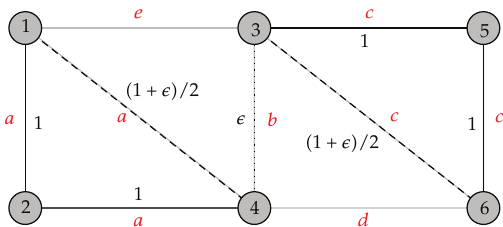
Figure 10: Valid LP-solution of EC tn with f lp (cid:6) 2 (cid:9) (cid:3) (cid:2) l a (cid:6) 1 ,l b (cid:6) (cid:3),l c (cid:6) 1 (cid:3) that is not valid for SCF tn . It can however be transformed to such, by increasing x 3 , 4 to 1/5, yielding f lp (cid:6) 2 (cid:9) 1 / 5. It is easy to see, that this solution is still not valid for DCut tn